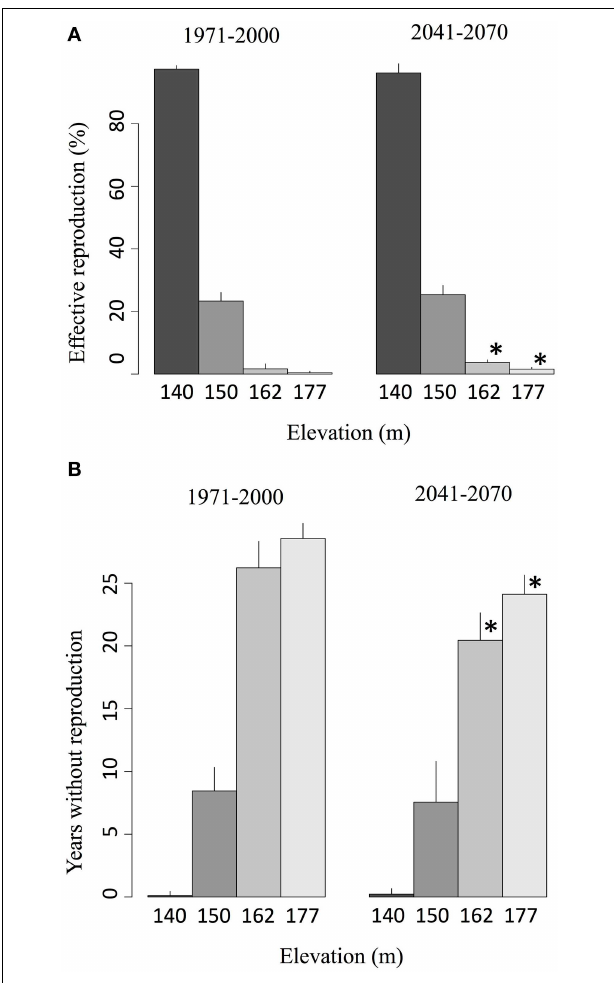
FIGURE 7 | (A) Average proportion of the reproduction season when a spring is active (effective reproduction window) given the projected activity time series for 140, 150, 162, and 177m elevations and (B) number of years during which reproduction is impossible due to the inactivity of the spring for each elevation. The values correspond to ensemble averages and error bars represent the standard deviation. The stars correspond to significant differences ( α = 0 . 05 ) between the reference climate (1971–2000) and the projected climate (2041–2070) according to a Wilcoxon-Mann-Whitney test for paired